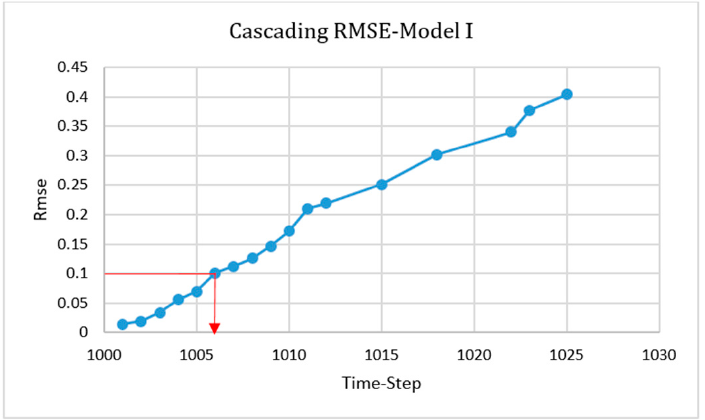
Figure 21. Root mean square equation (RMSE) of the cascading condition for Model Ⅰ .